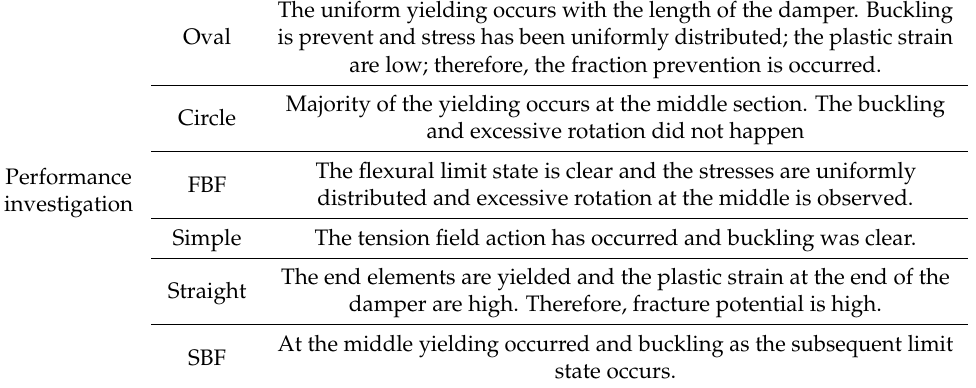
Table 5. The mode of behavior for MRLs up to at 0.08 drift